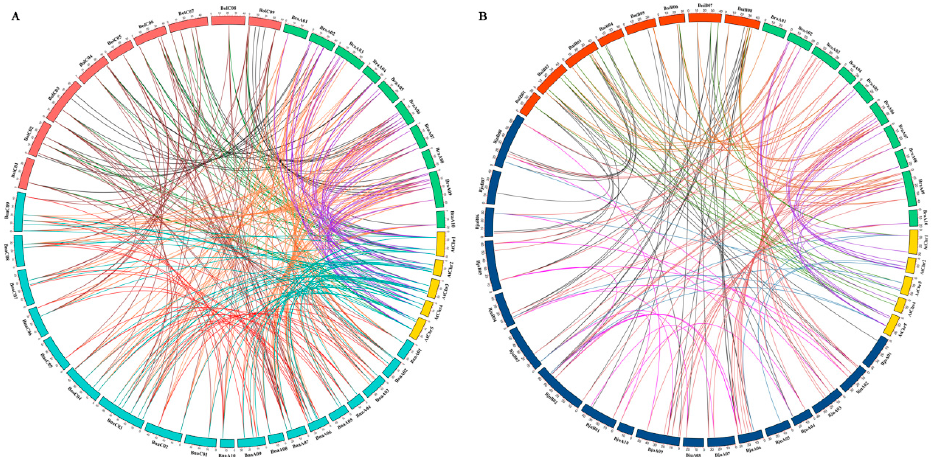
Figure 3. Genome-wide synteny analysis of PHT family genes among Arabidopsis and five Brassica species. ( A ) Collinearity analysis of PHT family genes among Arabidopsis , B. napus, B. rapa, and B.